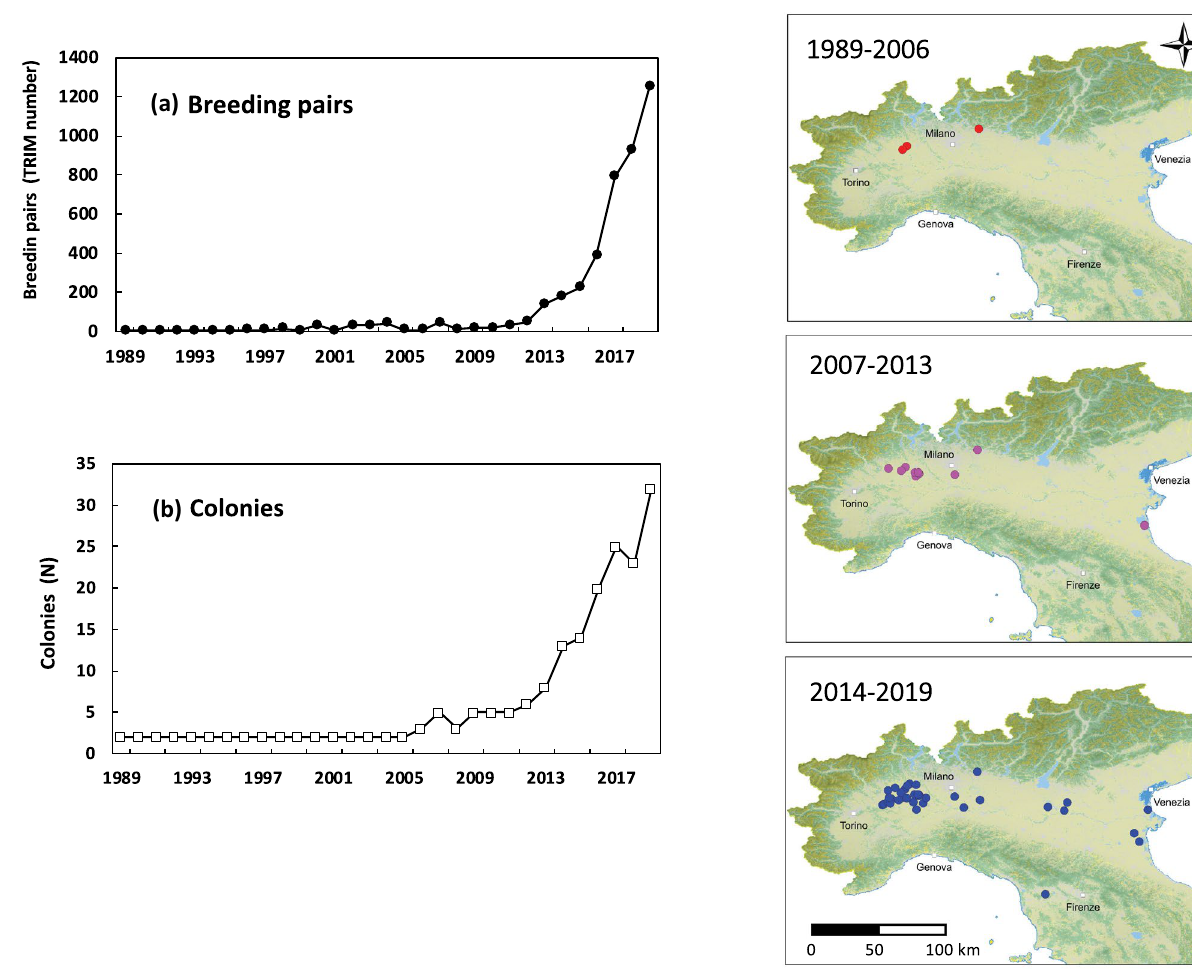
Figure 4. Sacred ibis presence at breeding colonies in the period from 1989–2019: ( a ) total number of pairs, TRIM estimates; ( b ) number of breeding colonies; ( c ) map of the breeding sites in Italy. Maps generated using QGIS ver, 3.4